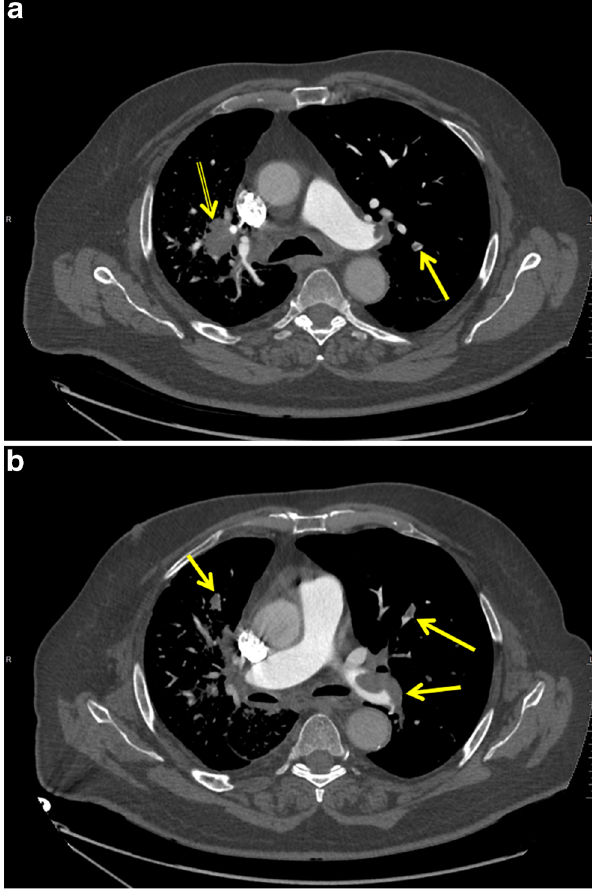
Fig. 2 Pulmonary embolism in a 73-year-old man with known stage IV non-small cell lung cancer. Axial reconstructions of a CT pulmonary angiography study at the carinal ( a ) and infracarinal ( b ) level showing a hilar mass ( double yellow arrow ) in the right upper lobe ( a ) and large emboli involving the left main pulmonary arteries as well as bilateral subsegmental emboli ( a , b ) ( yellow arrows